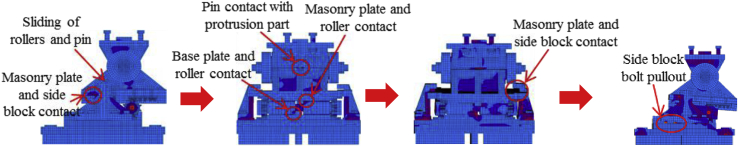
Contact and deformation performance (Case 3).